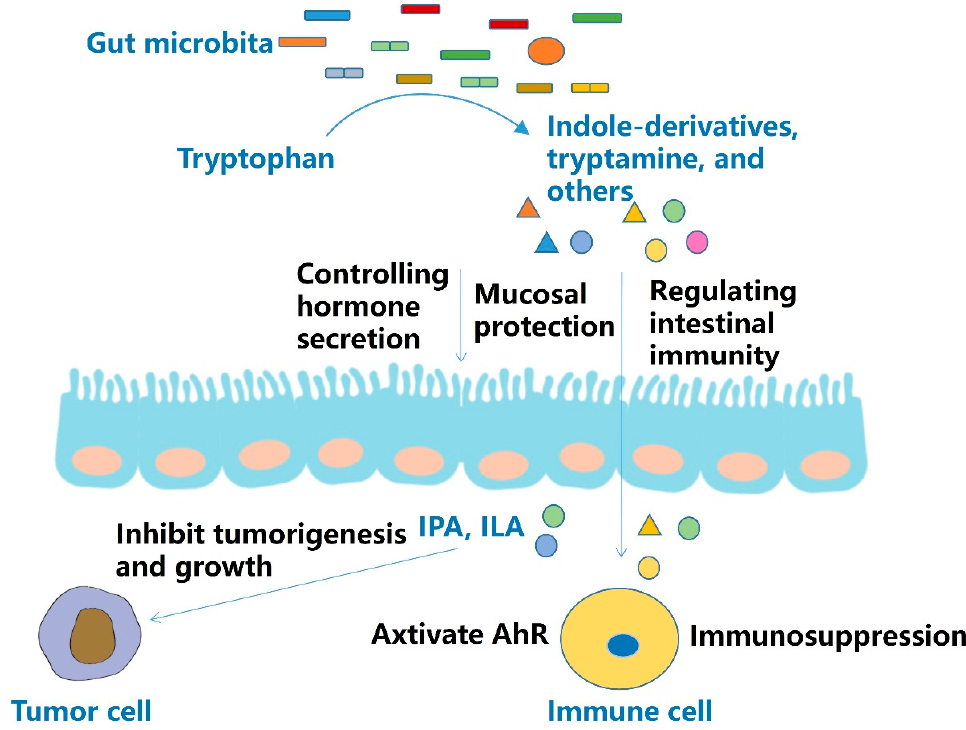
Figure 4. Effect and mechanism of tryptophan metabolites.